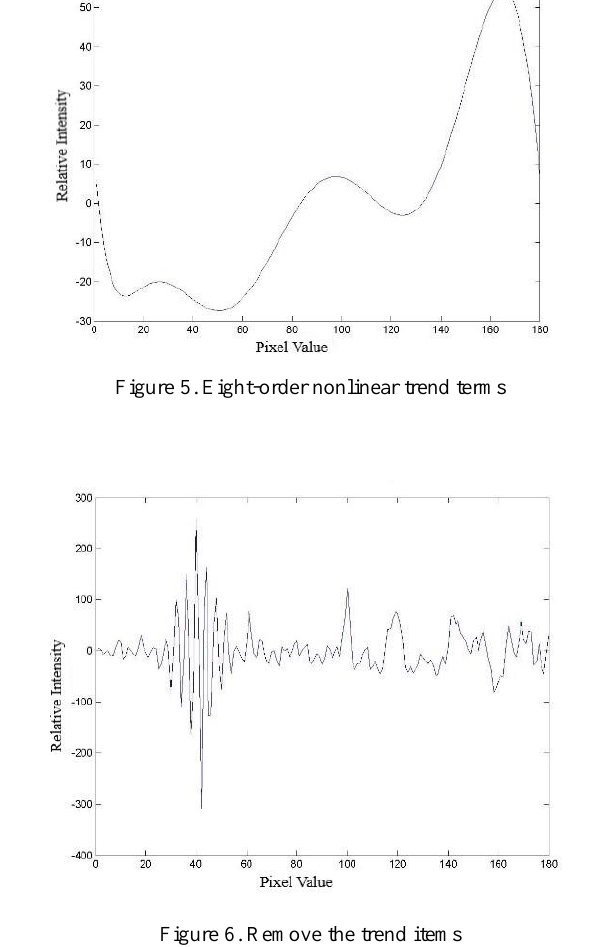
Figure 6. Remove the trend